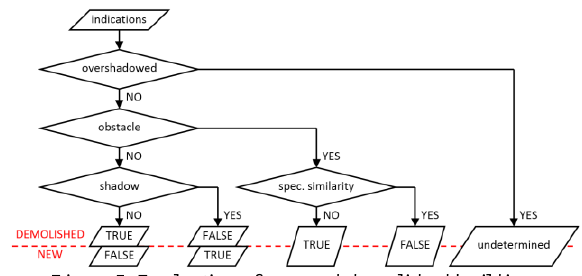
Figure 5. Evaluation of new and demolished buildings